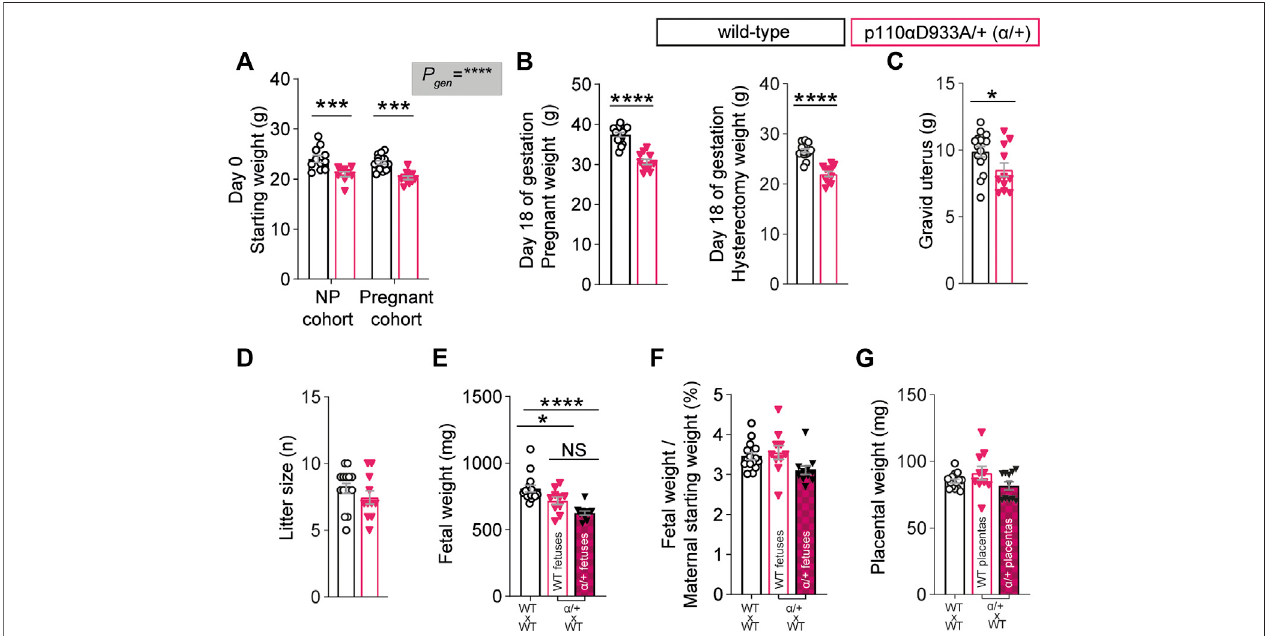
FIGURE 1 | PI3K-p110 α regulates maternal bodyweight and fetal growth. (A) Female starting weights ( n = 9 – 15 mice; two-way ANOVA) (B) Hysterectomised weights(afterremovaloftheuterus)ofthepregnantmice( n =11 – 15mice;two-wayANOVA). (C) Weightofthegraviduterus( n =11 – 15mice;unpairedStudent ’ s t -test). (D) Litter size ( n = 11 – 15 mice; unpaired Student ’ s t -test). (E) Fetal weights obtained from 11 to 15 dams (each dot represents a litter mean; one-way ANOVA). (F) Fetal weightdividedbymaternalweightatthestartofpregnancy(eachdotrepresentsalittermean;one-wayANOVA). (G) Placentalweightobtainedfrom11to15 dams (each dot represents a litter mean; one-way ANOVA). Data are individual-litter values and mean ± SEM.* p < 0.05; ** p < 0.01; *** p < 0.001; **** p < 0.0001. NS (not signi fi cant), NP (non-pregnant).